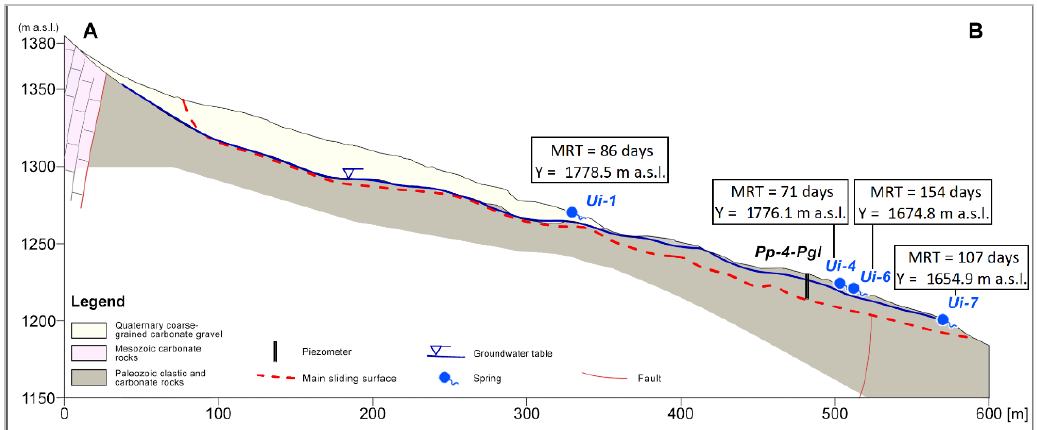
Figure 7. Cross-section (Figure 1) of the Urbas landslide.